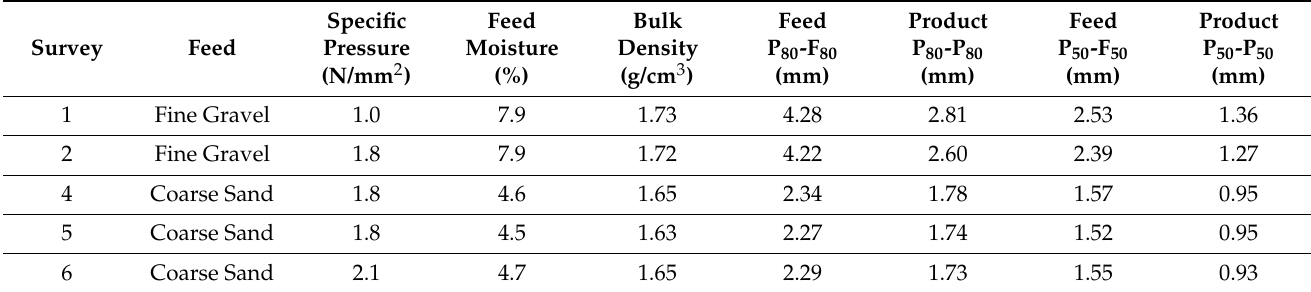
Table 5. Mass balance results—feed moisture, bulk density and particle size distribution